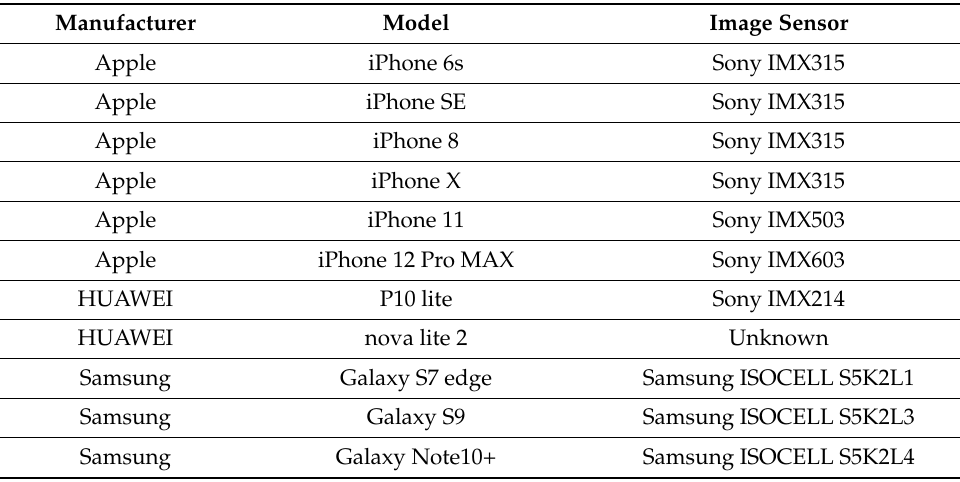
Table 1. Mobile phones measured in this